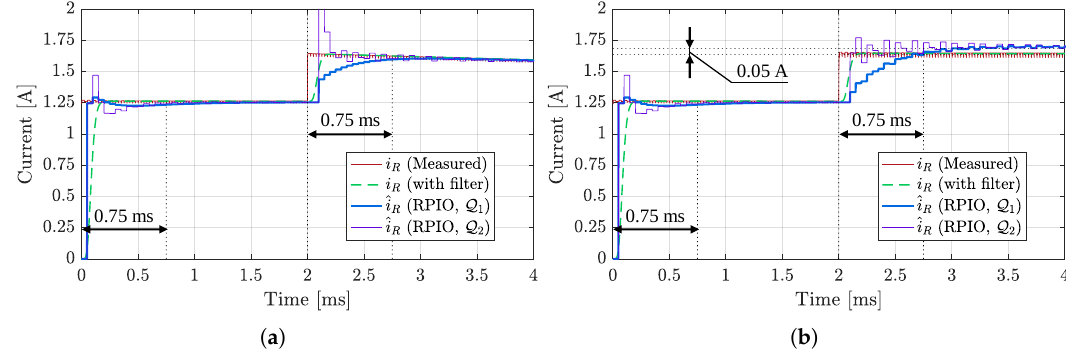
Figure 10. Simulation responses of the RPIO. ( a ) R load = 20 Ω ⇒ 15 Ω , ψ = 30 deg; ( b ) R load = 20 Ω ⇒ 15 Ω , ψ = 30 deg ⇒ 42